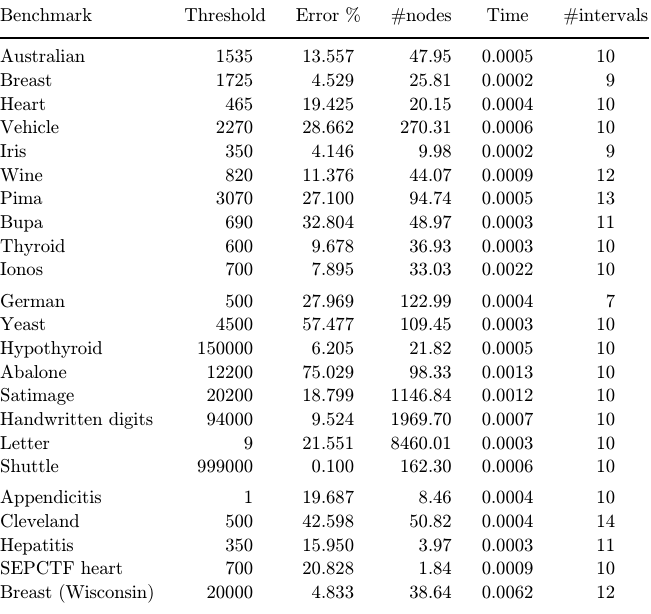
Table 3. Numerical results of ULR-Discr using the Pearson coe±cient.